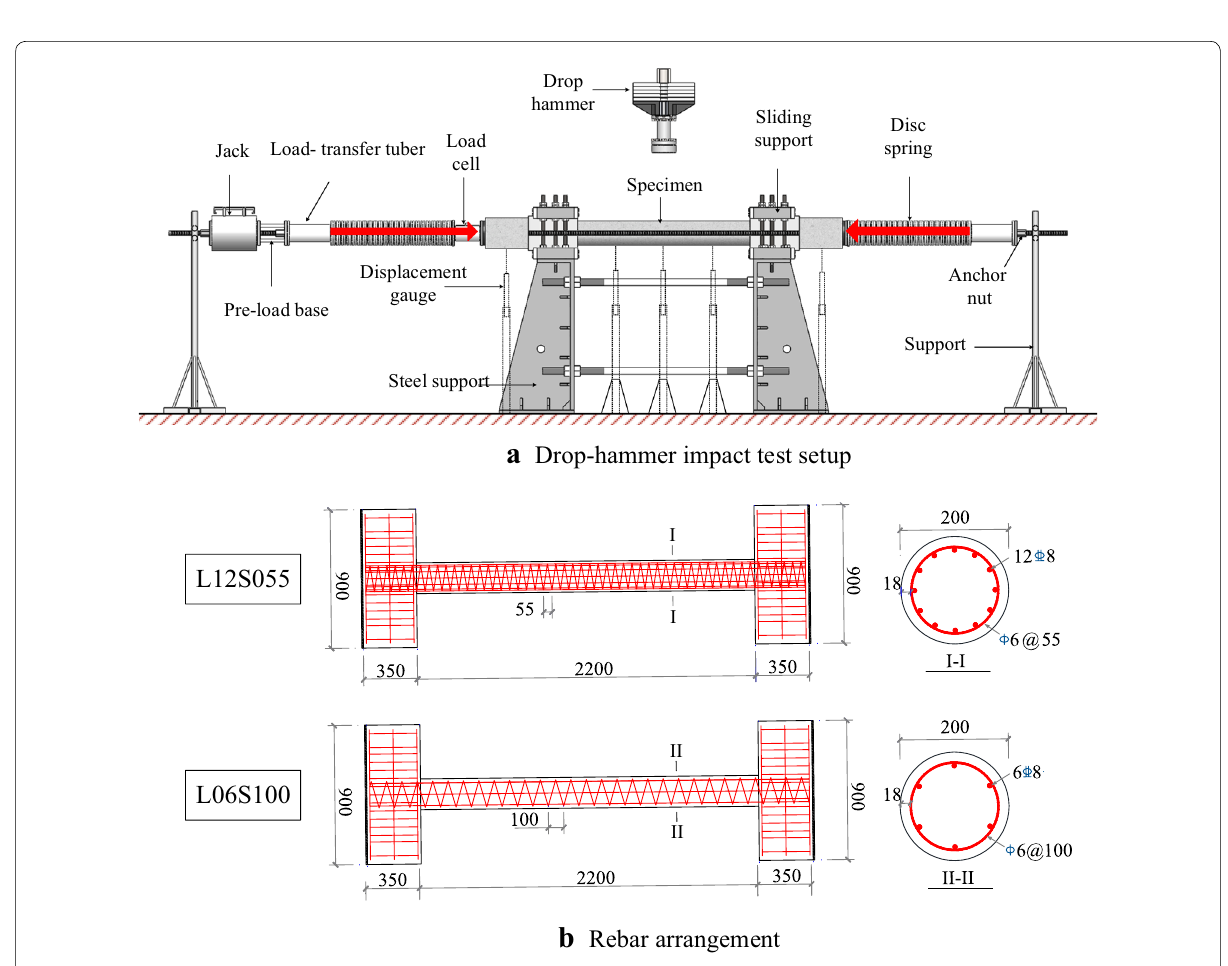
Fig. 7 Drop-hammer impact tests on axially-loaded circular RC columns: a test setup; b reinforcement layouts (Liu et al.